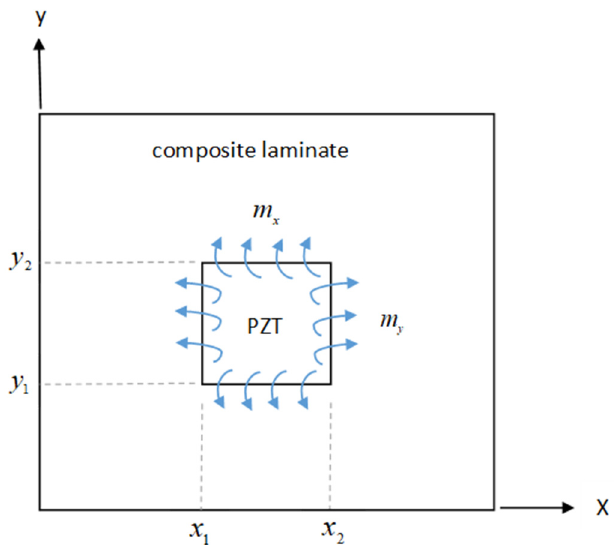
Figure 1. Schematic diagram of bending moments acting on the composite laminate.